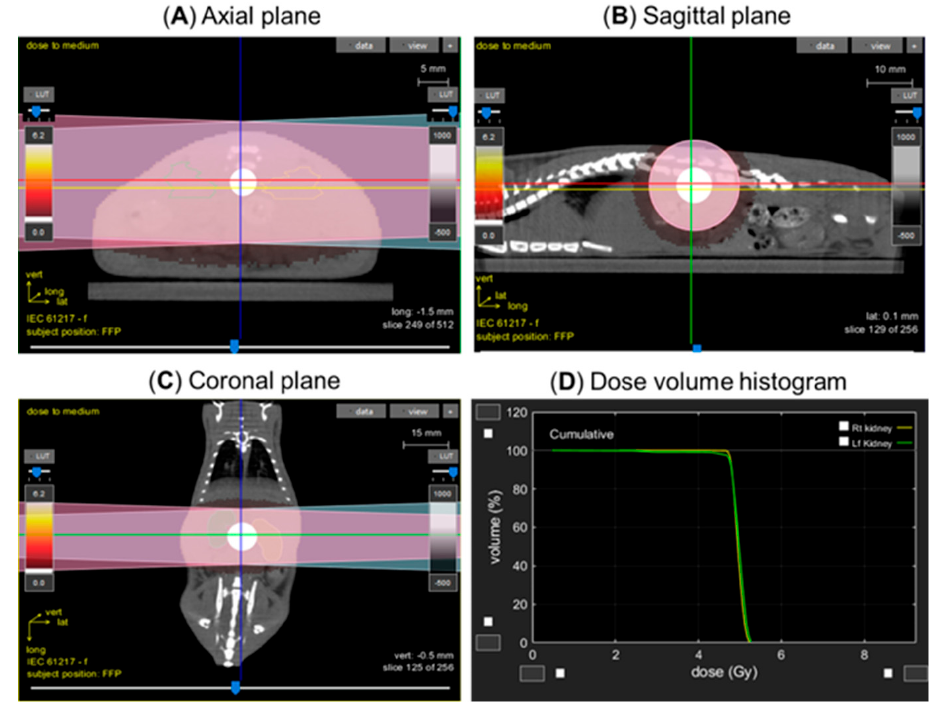
Figure 1. Image-guided localized kidney radiation technique. Computed tomography images of a representative male rat at 5–6 weeks of age with a 1.5-cm-diameter collimator plan of 5 Gy encompassing both kidneys in equally weighted beams (two laterals) are shown in the axial ( A ), sagittal ( B ), and coronal ( C ) planes. The kidneys are located within the central circle of each image. ( D ) dose volume histogram demonstrating dose to the